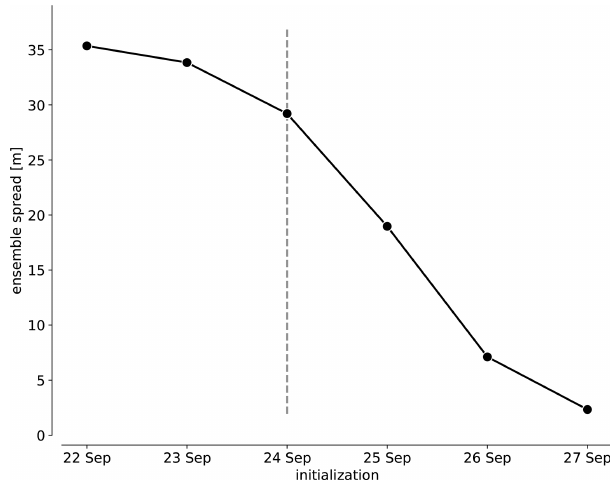
Figure 5. Area-averaged ensemble spread of geopotential height at 500hPa at 00:00UTC 27 September 2018 in a box over the Mediterranean (30–45 ◦ N, 5–30 ◦ E; see black box in Fig. 7) for ini- tializations at 00:00UTC 22 to 27 September 2018 (black dots and line). The initialization used in this study (00:00UTC 24 Septem- ber 2018) is indicated by the dashed